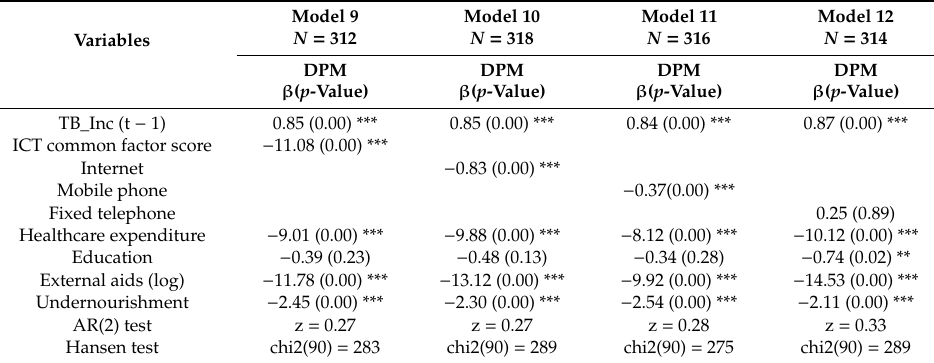
Table 4. Estimation results: ICT and tuberculosis